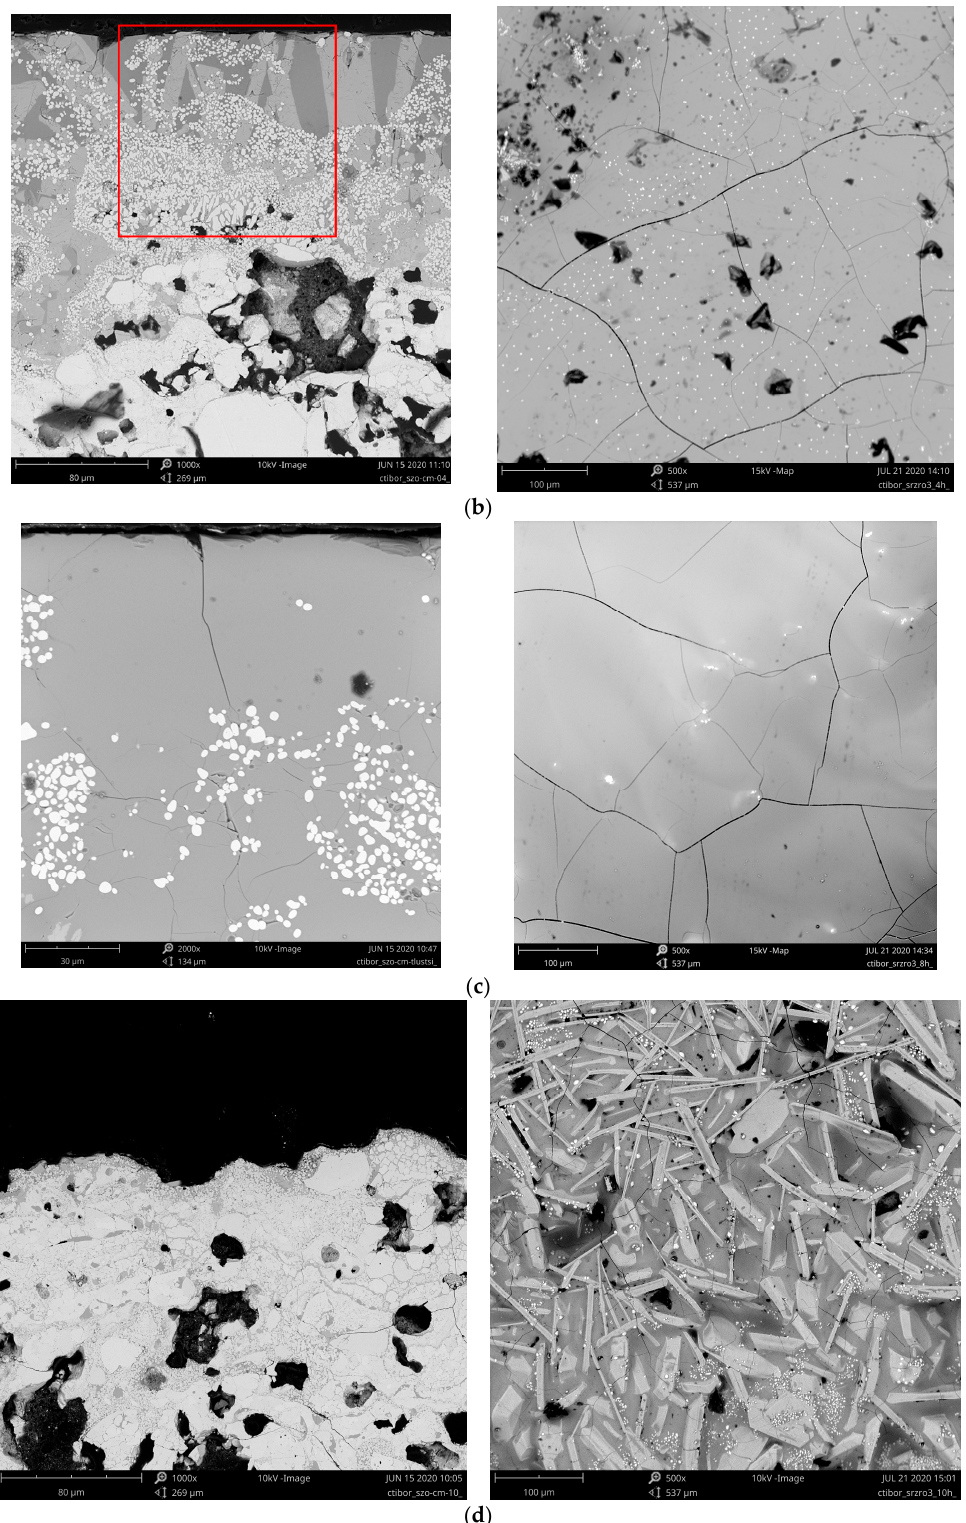
Figure 1. ( a ) SEM-BSE micrograph of polished cross section sample “1 h”; ( b ) SEM-BSE micrographs of polished sample “4 h”: cross section (left) and surface; ( c ) SEM-BSE micrographs of polished sample “8 h”: cross section (left) and surface; ( d ) SEM-BSE micrographs of polished– sample “10 h”: cross section (left) and